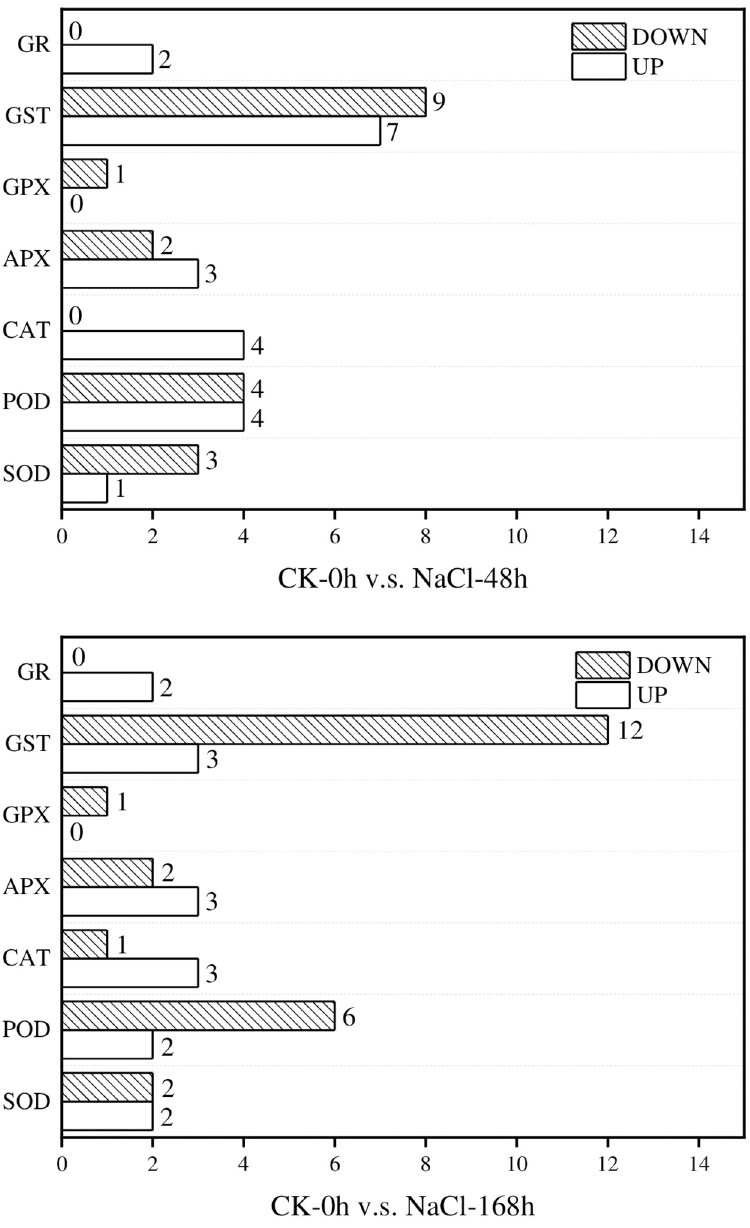
Fig 7. Antioxidant mechanism related genes under NaCl treatment in T . ramosissima . (Notes: GR, glutathione reductase; GST, glutathione S-transferases; APX, ascorbate peroxidase; GPX, glutathione peroxidase; CAT, Catalases; POD, peroxidase; SOD, Superoxide dismutase. The number of up-regulated and down-regulated activities of each enzyme in the reactive oxygen species scavenging mechanism shown in the figure in the comparison of CK V.S. NaCl- 48h and CK V.S.